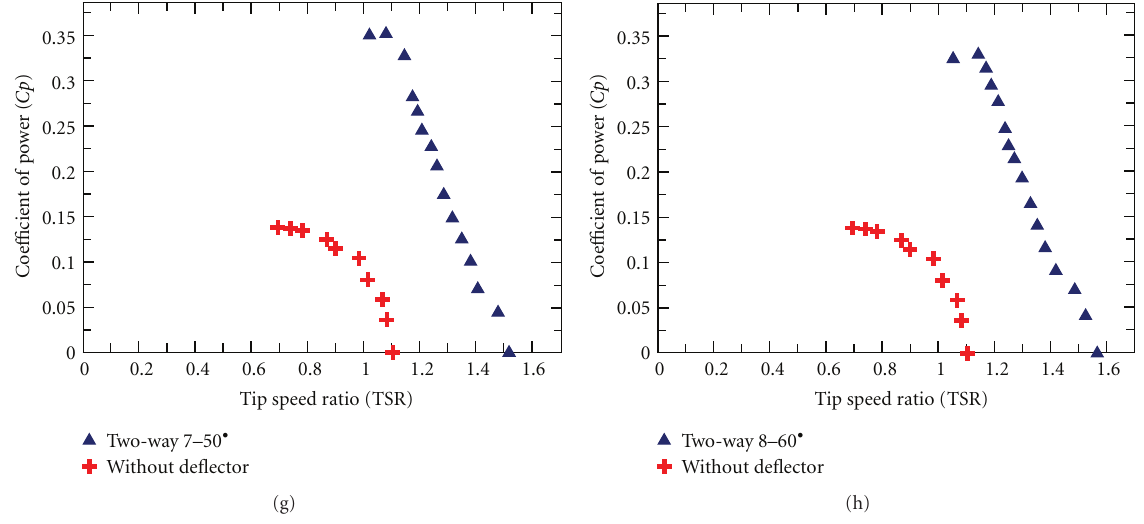
Figure 11: Variation of coe ffi cient of power with TSR for modified Savonius rotor with and without two deflector plates.